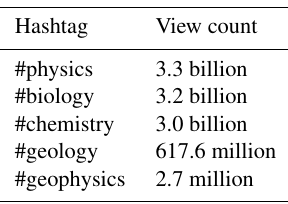
Table 1. Number of total video views on TikTok for different science-related hashtags as of October 2021, before our project be- gan. Within the app, TikTok denotes the total number of video views per